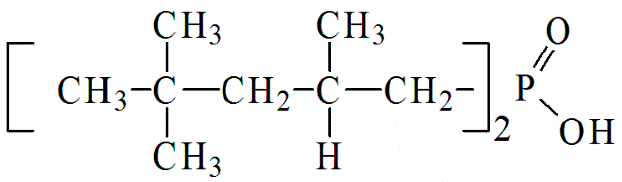
Figure 1. Structure of cyanex 272.